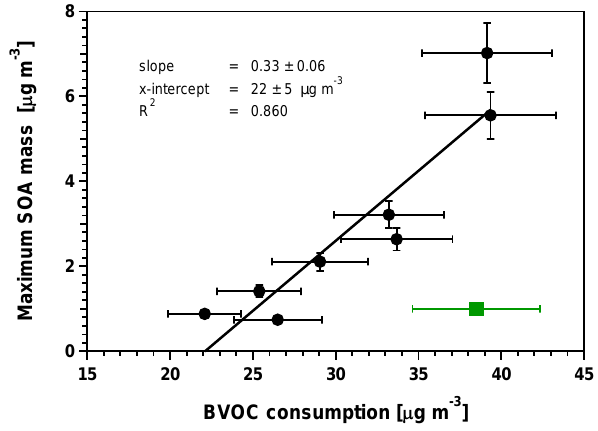
Fig. 7. Maximum BSOA mass versus consumption of C 17 -BVOC- dominated emissions in Experiment #3. Black circles: data obtained at low contribution of GLV. Green square data point obtained on day 0 at high GLV emissions (see Fig.